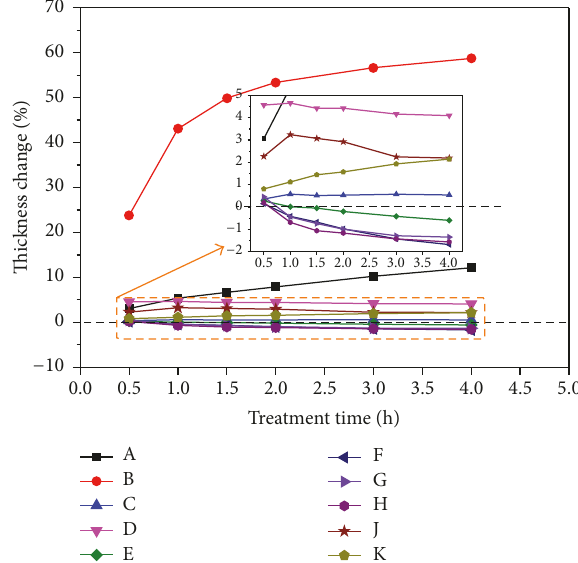
Figure5:Thicknesspercentagechangeofbambooscrimbersduring 4-hour treatments. A, B, and K: water immersion at 63 ∘ C, 100 ∘ C, and 25 ∘ C; C and D: oil immersion at 100 ∘ C and 150 ∘ C; E, F, and G: air drying at 63 ∘ C, 100 ∘ C, and 150 ∘ C; H and J: infrared drying at 100 ∘ C and 150 ∘